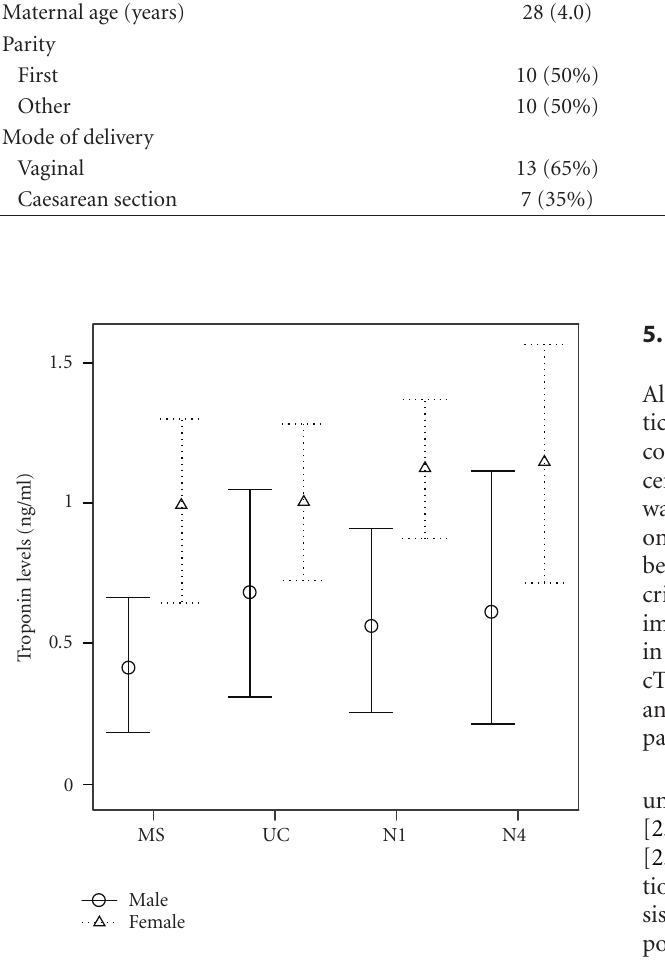
Figure 2: Cardiac troponin-I (cTnI) levels in maternal (MS), fe- tal (UC), neonatal day 1 (N1), and neonatal day 4 (N4) serum of pregnancies with intrauterine growth-restricted (IUGR) male and female o ff